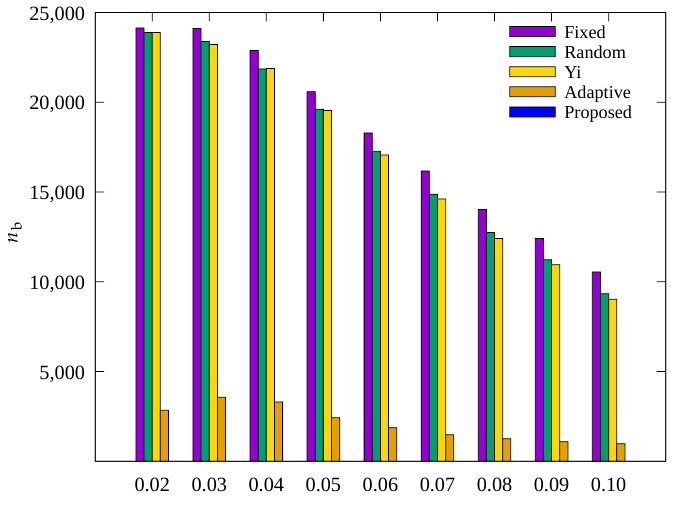
Figure 14. Change in total number of blackout nodes according to density.